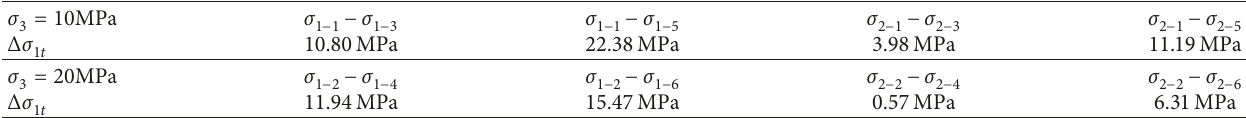
Table 5: Strength difference of the filled cracked